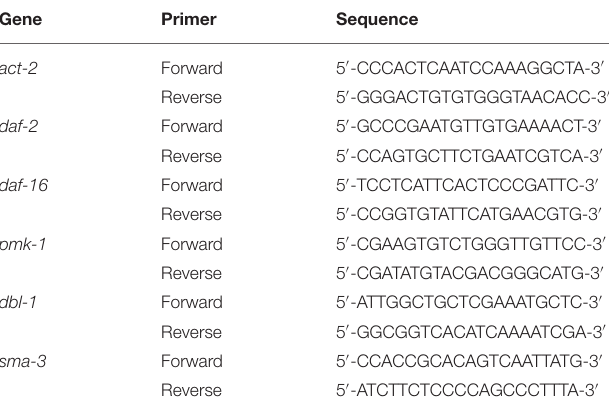
TABLE 1 | The primer sequence used in this